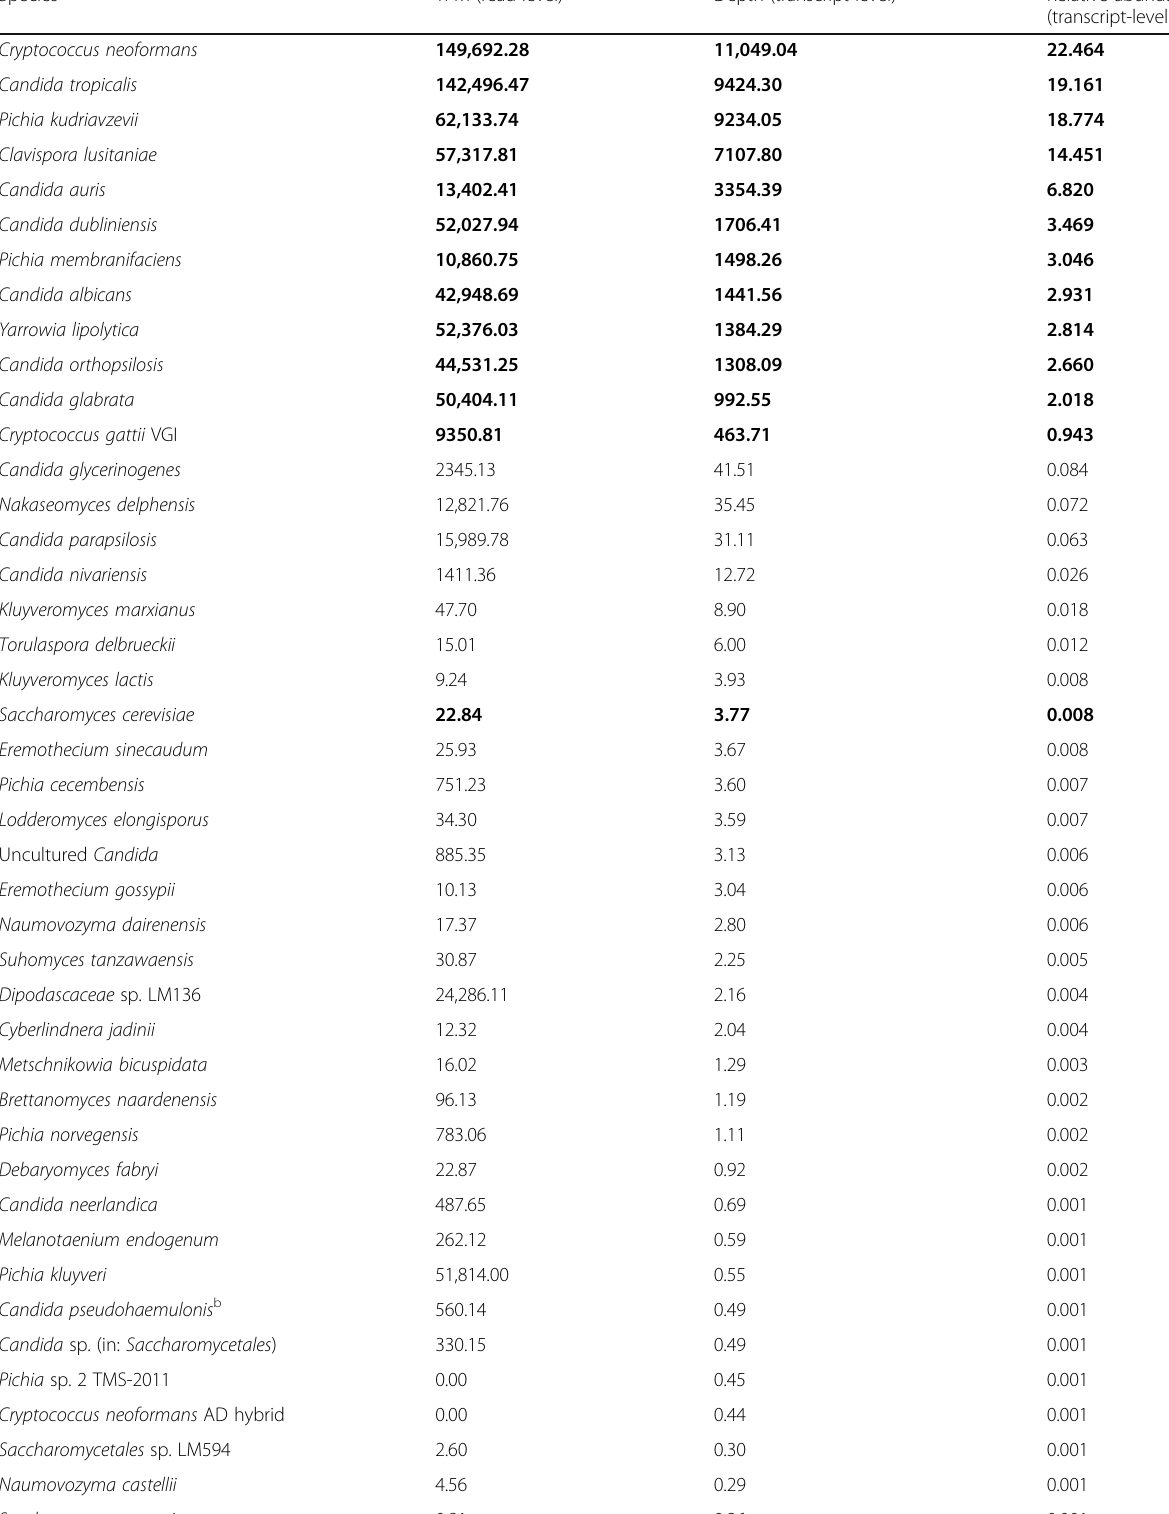
Table 2 Abundance of reads (TPM) and abundance of transcripts (Depth) per fungal species detected with metatranscriptomics. True members of the mock community – at species level – are shown in bold Species